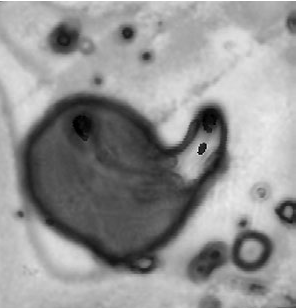
Fig. 5. SAM image taken from the inner layers